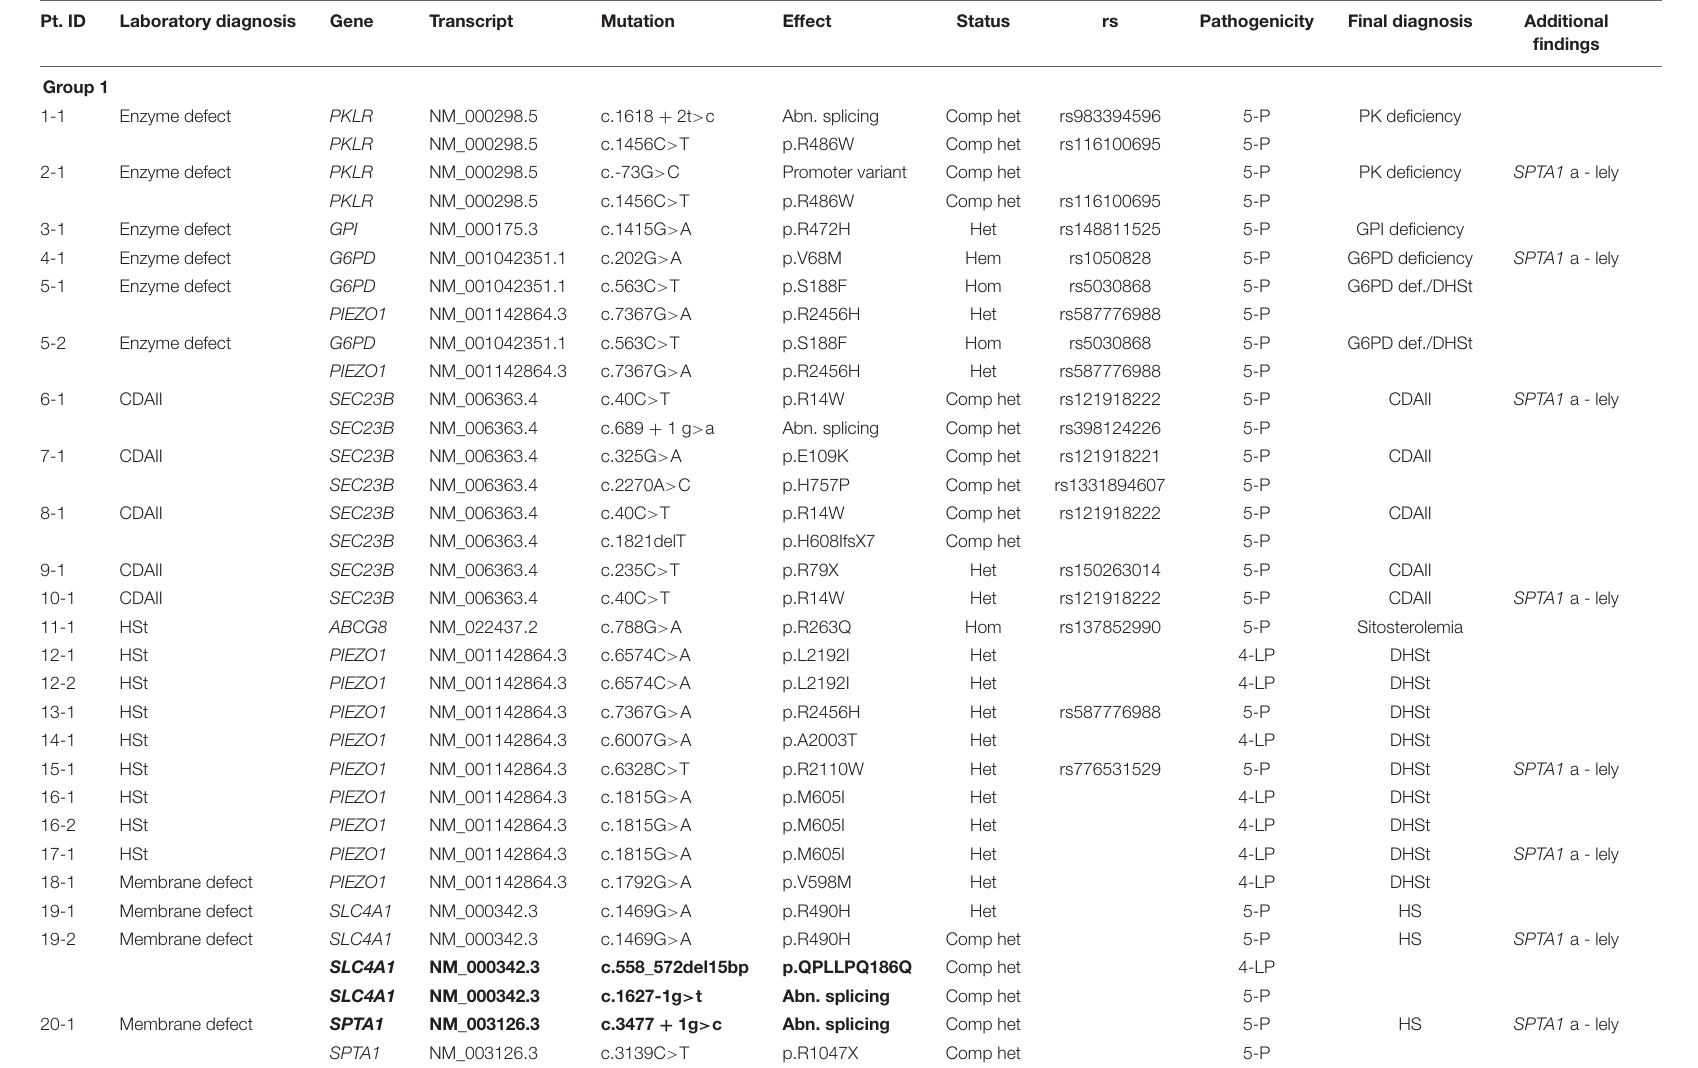
TABLE 1 | Results of NGS analysis in 64 patients with congenital hemolytic anemia. Pt.